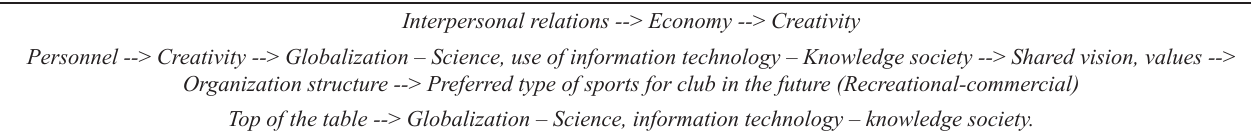
Table 2. Experimental sample – Meaningful core of the system – statistical significant correlations based on Figure